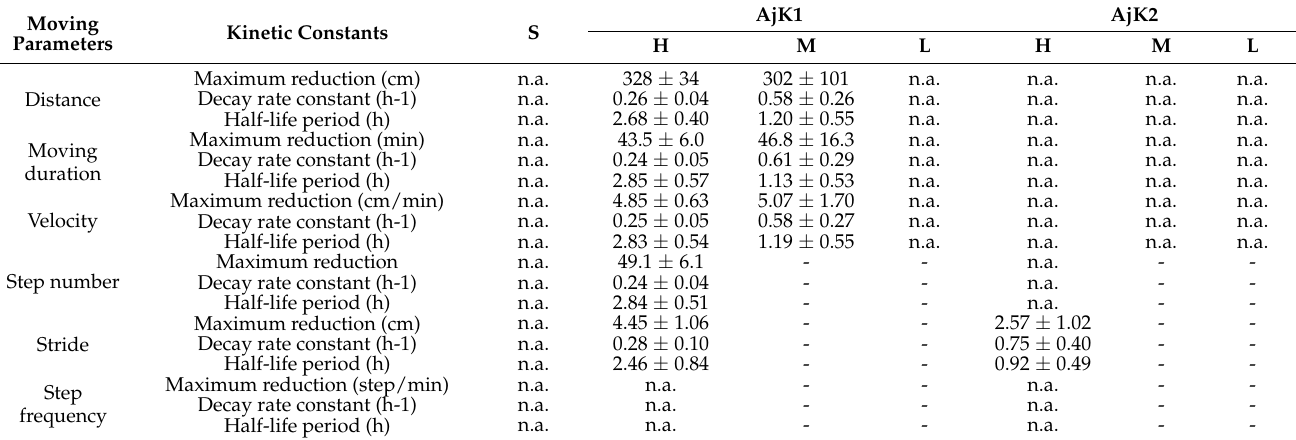
Table 2. Kinetic parameters of KPs acting on the behavior of A. japonicus